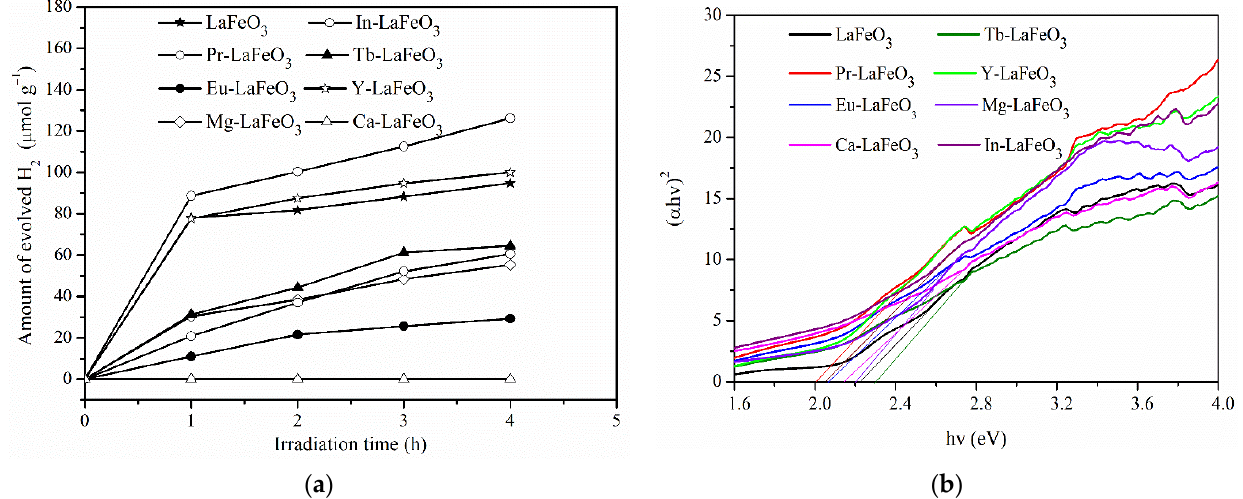
Figure 1. ( a ) The hydrogen evolution and ( b ) DRS curves of different metal doped LaFeO 3